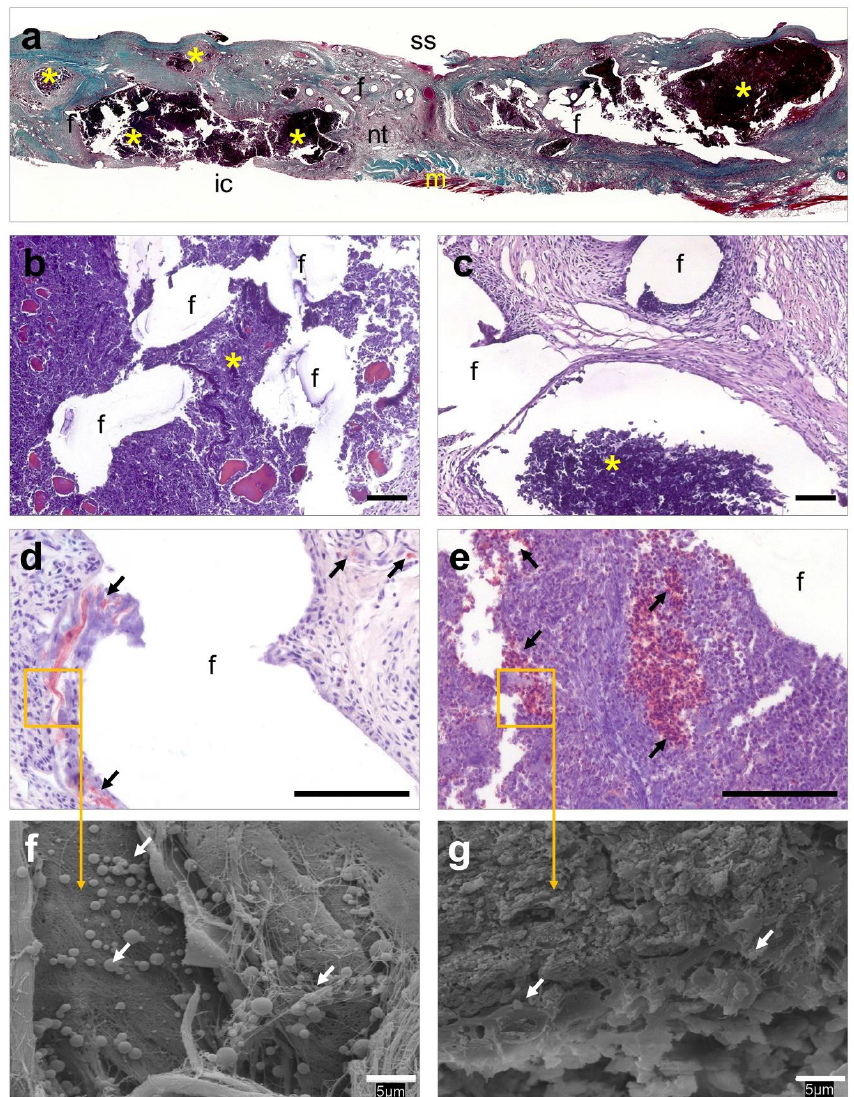
Figure 5. Histological evaluation of the HApN implants. ( a ) Panoramic view of an implant displaying several abscesses that disrupt tissue integration (Masson’s trichrome, × 50). ( b , c ) Detail of different areas of the implant showing a dense connective tissue surrounding the mesh filaments, containing different-sized abscesses next to the mesh filaments (hematoxylin eosin, ×100). ( d , e ) Presence of bacteria was immunohistochemically confirmed in neoformed tissue and within abscesses (Sa immunostaining, ×320). ( f , g ) At higher magnification, bacteria were visualized forming colonies firmly adhering to the implant surface and within the abscesses (scanning electron microscopy, SEM, ×2000). Symbols: (ic) intraperitoneal cavity; (f) mesh filaments; (m) muscle; (nt) neoformed tissue; (ss) subcutaneous side; (*) abscess; ( ) bacteria. Scale bars represent 100 µm (b–e) and 5 µm (f,g).